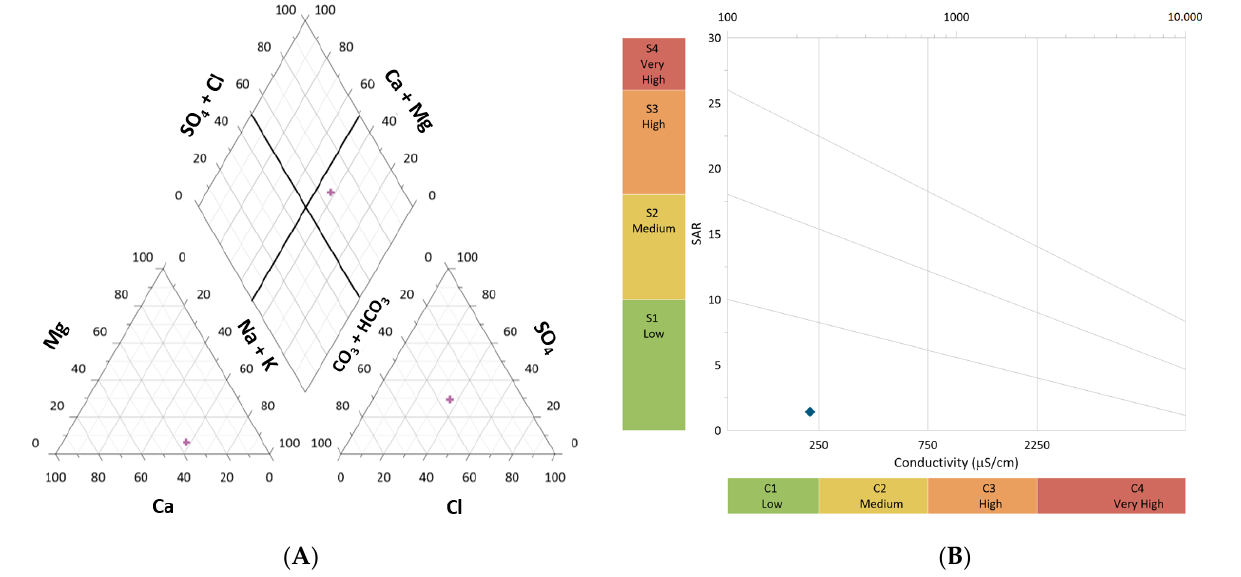
Figure 1. Physicochemical characterization of irrigation water in the vineyard of Syrah. Projection of water sample with ( A ) Ternary Piper diagram and ( B ) Wilcox diagram.